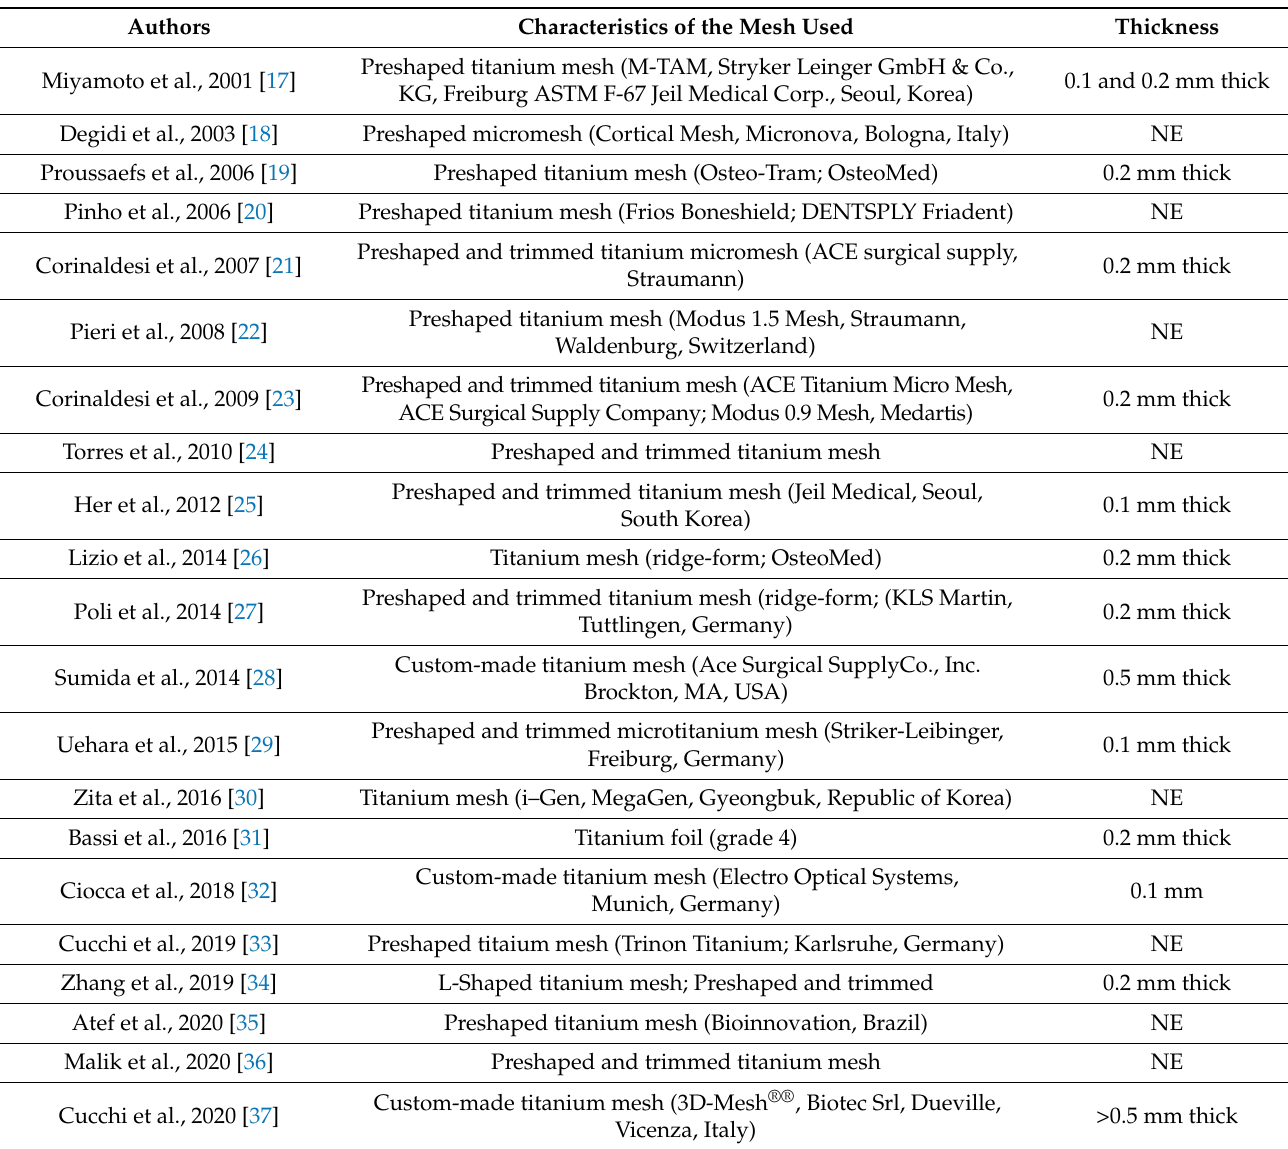
Table 4. Characteristics of the meshes